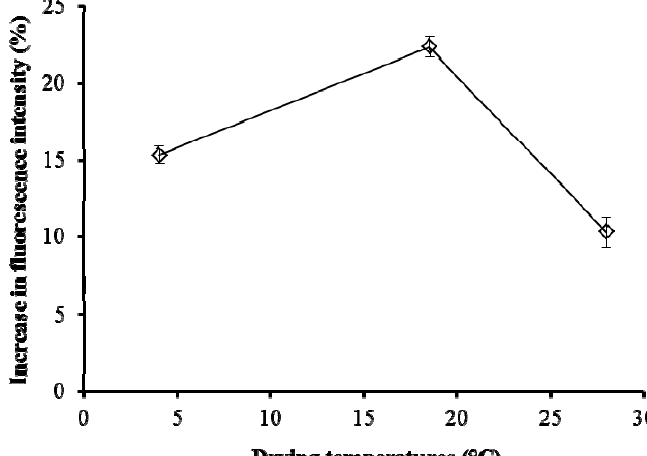
Figure 5. The effect of drying temperature of pHEMA to the increase of fluorescence